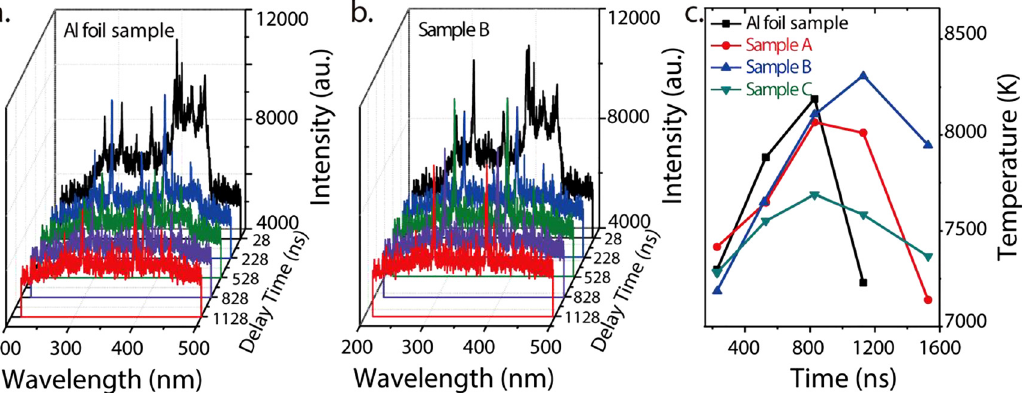
Figure 4: (a, b) LIBS spectra in the wavelength ranges of 200 – 500 nm for Al foil and Sample B. (c) The calculated electron temperature in plasma in terms of the peak intensity pro fi le via the Boltzmann plot method.